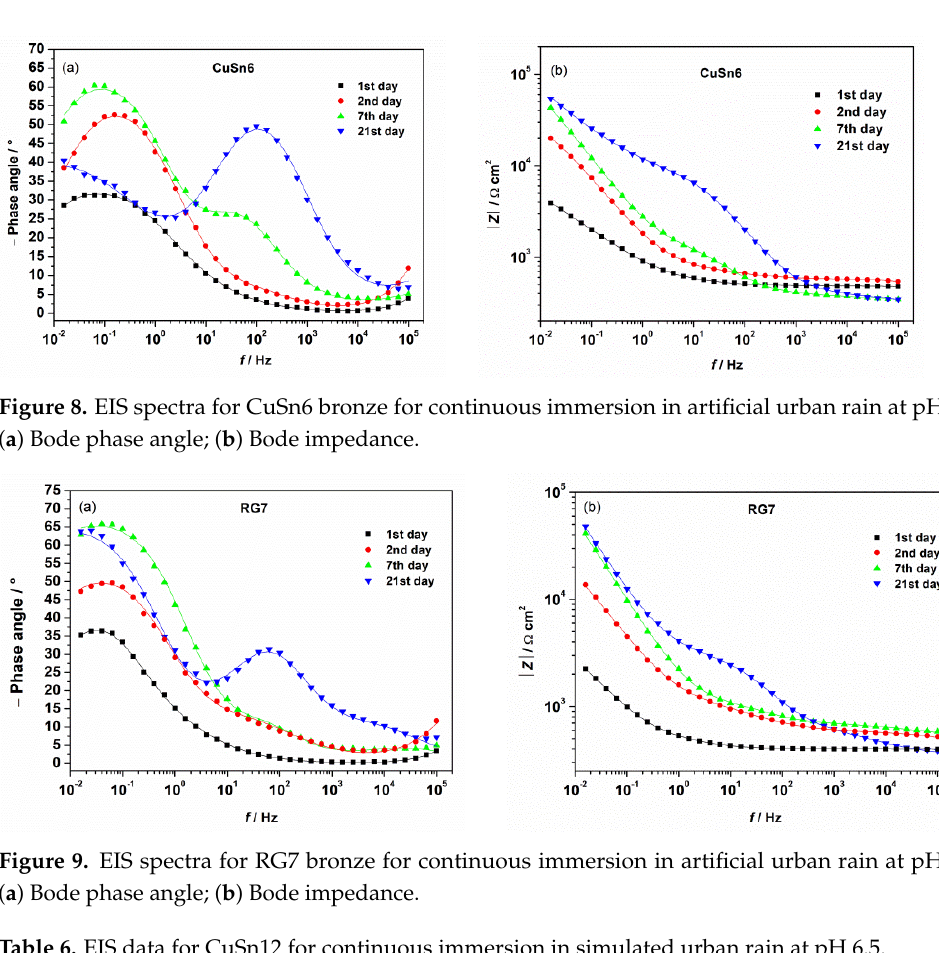
Figure 7. EIS spectra for CuSn12 bronze for continuous immersion in artificial urban rain at pH 6.5. ( a ) Bode phase angle; ( b ) Bode impedance.